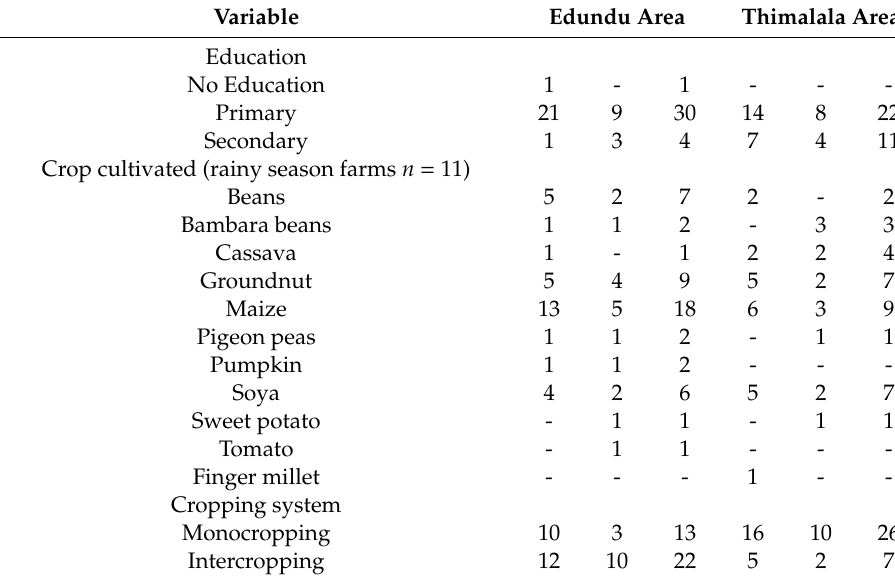
Table 1. Characteristics of the study